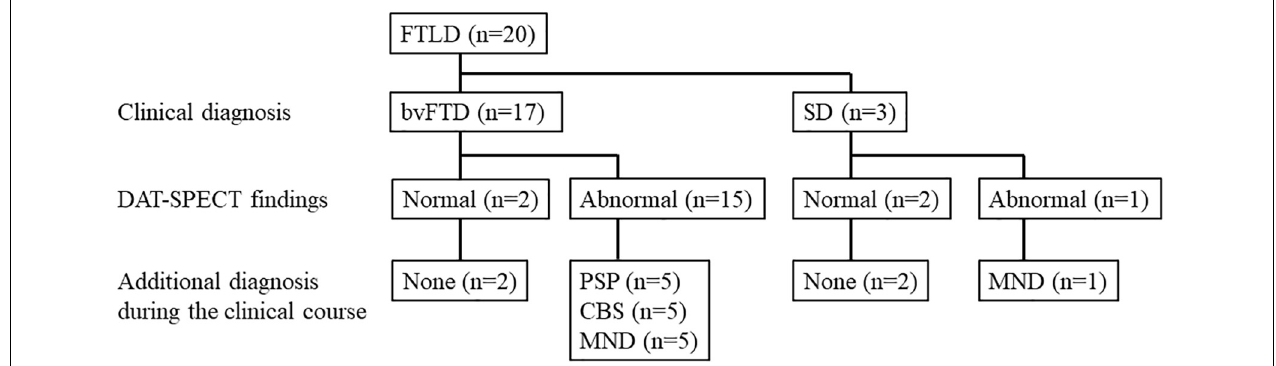
FIGURE 1 | Study flow chart. bvFTD, behavioral variants of frontotemporal dementia; CBS, corticobasal syndrome; DAT-SPECT, dopamine transporter single photon emission computed tomography; FTLD, frontotemporal lobar degeneration; MND, motor neuron disease; PSP, progressive supranuclear palsy; SD, semantic dementia.